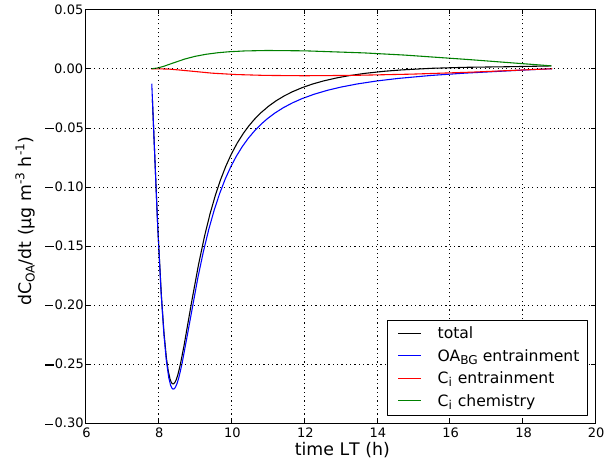
Fig. 8. Organic aerosol tendency (Eq. 4) for the case study. Shown are the total tendency and the contributions of the entrainment of background organic aerosol (OA BG ), the entrainment of condens- able products from terpene oxidation ( C i ), and the chemical pro- duction of C i to the